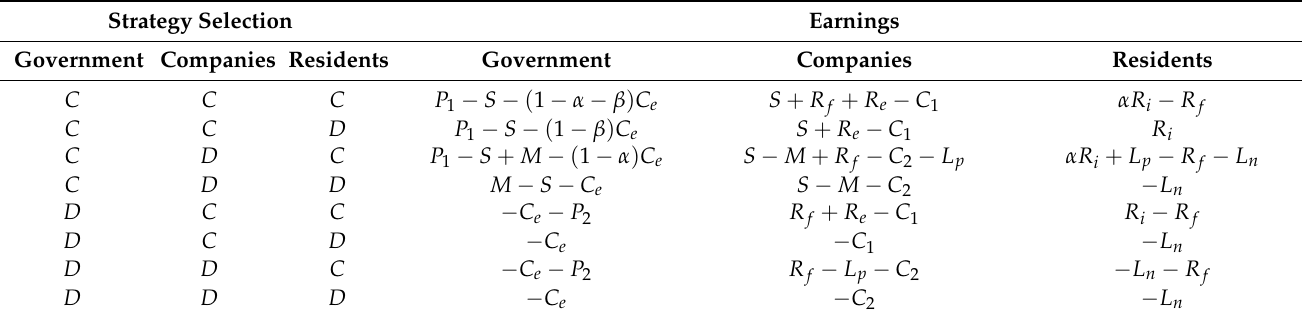
Table 2. The matrix of benefits of the three-party